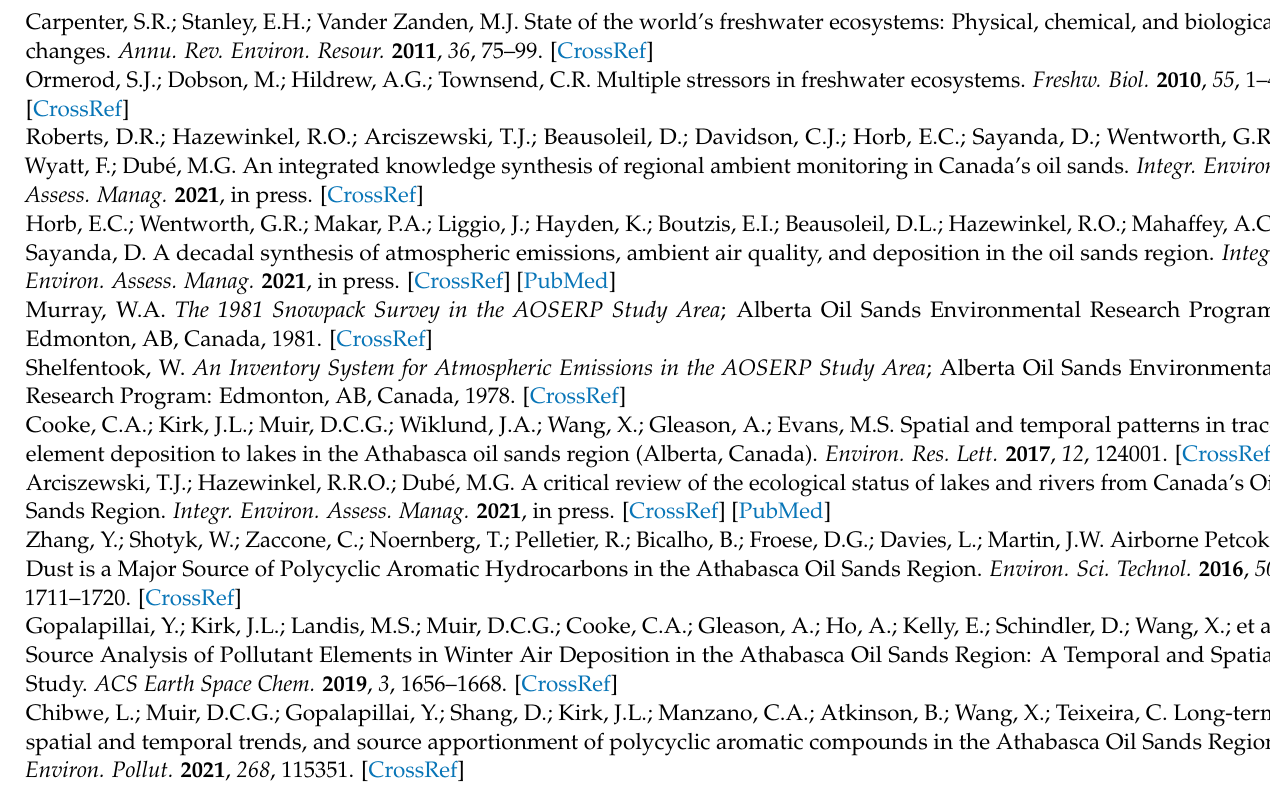
Figure S6: Mining and in situ production (thousands of barrels per day) over time; data obtained from www.oilsandsmagazine.com (accessed on 5 October